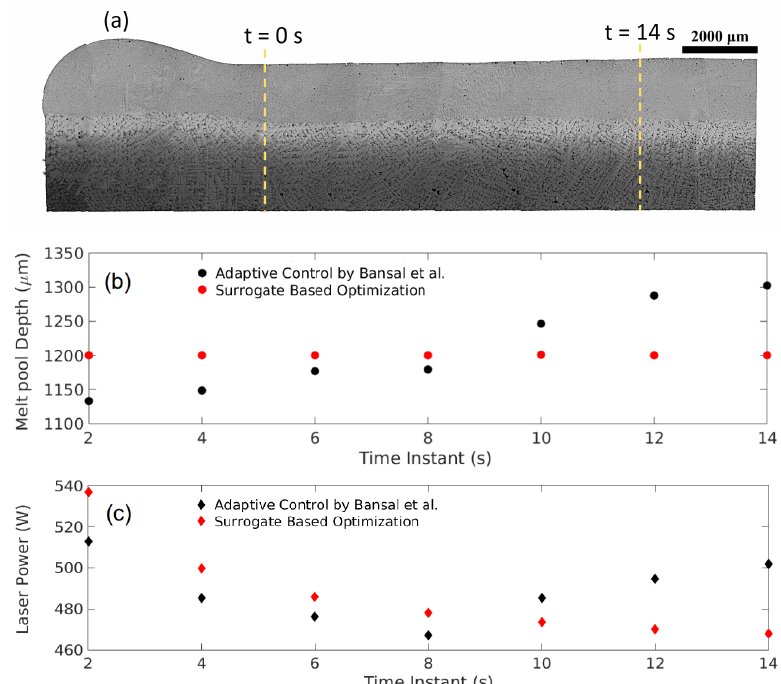
Figure 13. ( a ) Longitudinal cross section showing a René 80 specimen fabricated using an adaptive control scheme (Reproduced from [63], with permission of the author). ( b ) Melt pool depth as a function of time. ( c ) Controlled laser power as a function of time, obtained by the adaptive control scheme of Bansal [63], compared with the results from surrogate based optimization method. The black markers in ( b , c ) show the variation in the melt pool depth and laser power as a function of time during the time of control. The red markers in ( b , c ) show the variation in the melt pool depth and laser power obtained by the BO